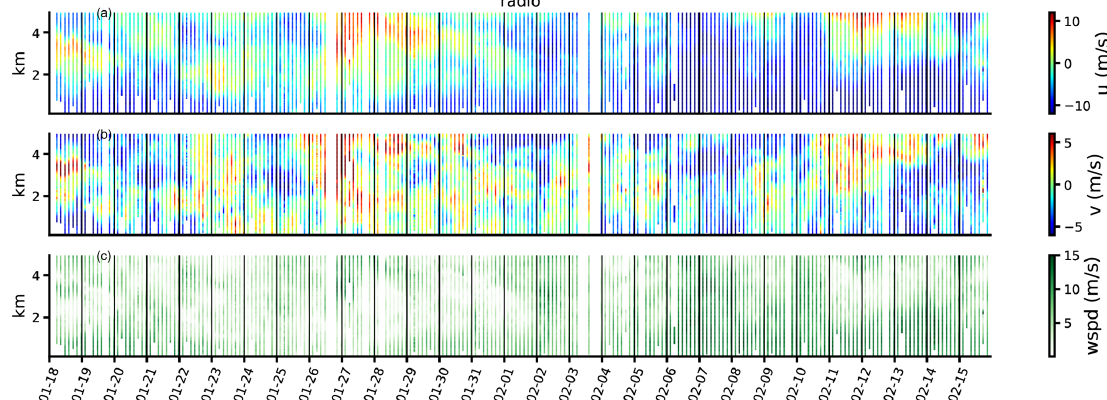
Figure 6. Time series of 3-hourly zonal wind (a) , meridional wind (b) , and wind speed (c) from radiosondes averaged over the whole domain.